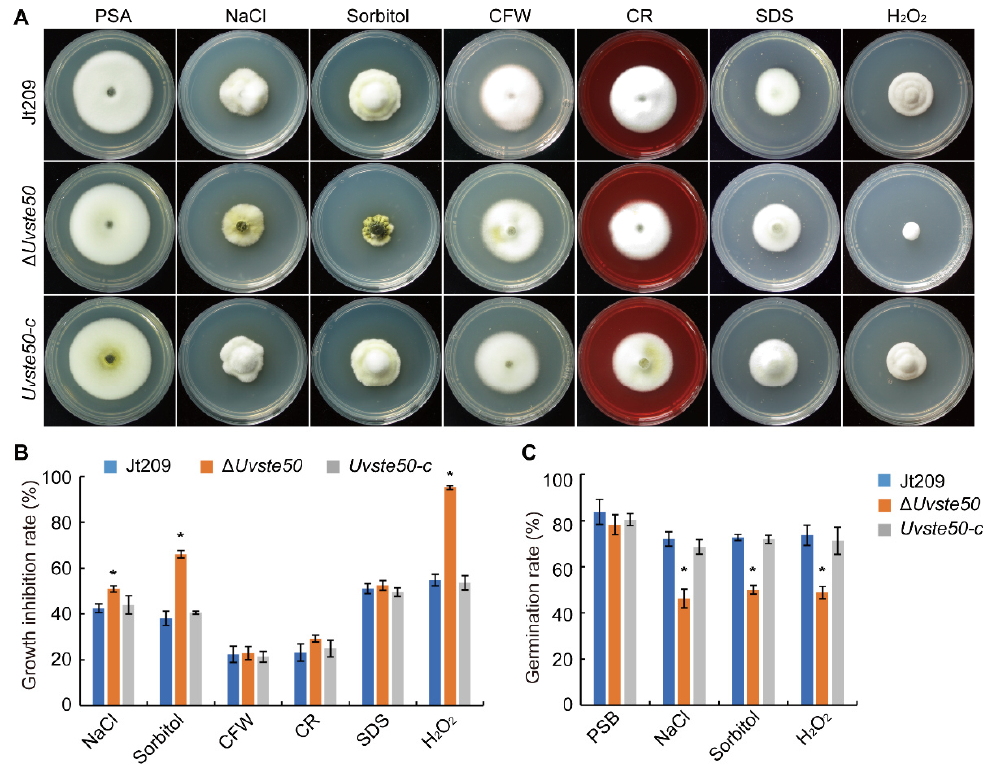
Figure 6. UvSTE50 regulates stress responses in U. virens . ( A ) Mycelial radial growth of the wild-type strain Jt209, ∆ Uvste50 mutant, and the complemented strain Uvste50-c on PSA or PSA containing exogenous stress agents including 0.5 M NaCl, 0.6 M sorbitol, 500 µ g/mL CFW, 100 µ g/mL CR, 0.05% SDS, or 0.05% H 2 O 2 . Photographs were obtained after incubation at 28 ◦ C for 20 days in the dark. ( B ) The growth inhibition rate of strains cultured on plates with different stress agents. Measurements of growth inhibition rate were calculated relative to the growth rate of each untreated control. Mean and standard deviation were calculated from three replicates. ( C ) Conidia germination rates were analyzed after treatment without or with 0.3 M NaCl, 0.3 M sorbitol or 0.01% H 2 O 2 for 20 h. Bar, 20 µ m. * represent significant differences between the mutant ∆ Uvste50 and wild-type strain Jt209, as estimated by Duncan’s new multiple range test ( p <